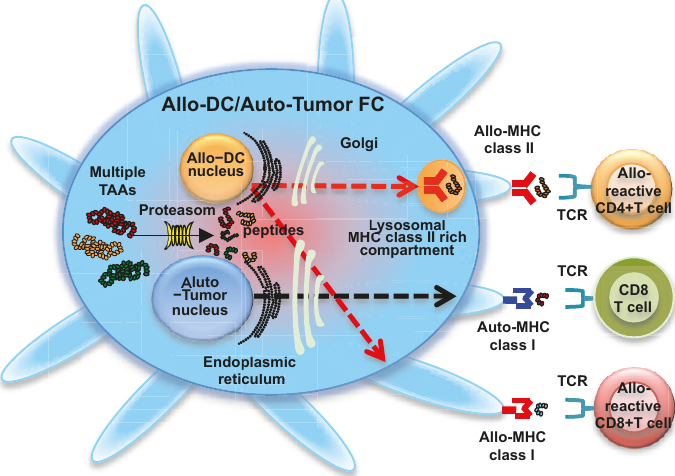
Figure 3. Fusion cells generated with allogeneic dendritic cells and autologous tumor cells. Fusions of allogeneic dendritic cells (Allo-DCs) and autologous tumor cells (Allo-DC/Auto-Tumor FC) display a characteristic phenotype comprised of MHC class I molecules from allogeneic DCs and autologous tumor cells, MHC class II molecules from allogeneic DCs, co-stimulatory molecules (CD80 and CD86), and multiple tumor-associated antigens. Multiple tumor-associated antigens from autologous tumor cells are degraded by proteasome in Allo-DC/Auto-Tumor FC (solid line arrow), and antigenic peptides are loaded onto MHC class I molecules from allogeneic DC (red-colored dash line arrow) and autologous tumor cell (black-colored dash line arrow) in the endoplasmic reticulum. The peptide-MHC class I complexes are then expressed on the Allo-DC/Auto-Tumor FC surface and stimulate polyclonal antigen-specific CD8 + T cells and alloreactive CD8 + T cells. Allo-DC/Auto-Tumor FC can also synthesize MHC class II-restricted antigenic peptides in the endoplasmic reticulum. These are transported to the cytoplasm, where peptide-allogeneic MHC class II complexes are generated (red-colored dash line arrow). Peptide-allogeneic MHC class II complexes are also expressed on the Allo-DC/Auto-Tumor FC surface and activate alloreactive CD4 + T cells. Moreover, antigens derived from Allo-DC/Auto-Tumor FC are also be cross-presented by host DCs, resulting in the induction of polyclonal antigen-specific CD4 + and CD8 + T